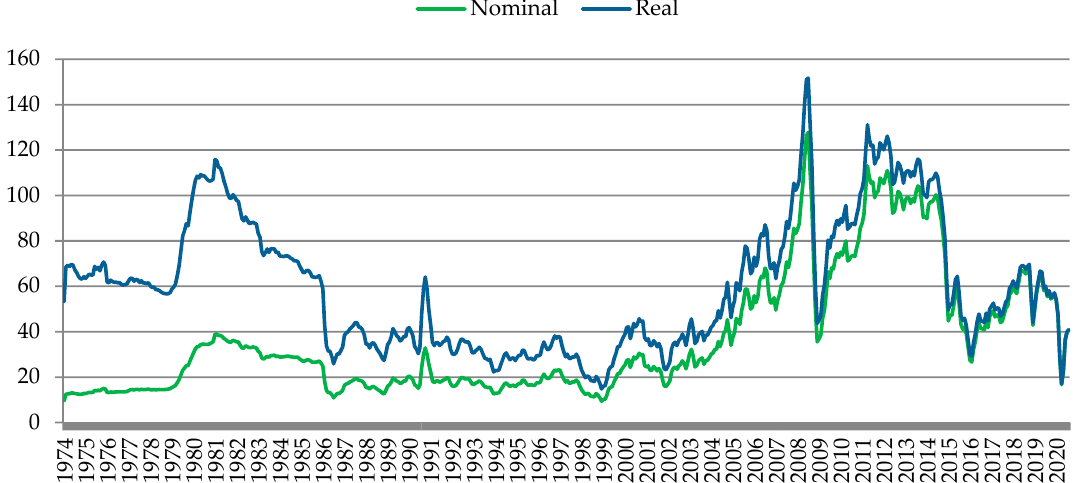
Figure 1. Monthly imported crude oil prices from January 1974 until August 2020 (USD per barrel). Source: own elaboration based on [9].